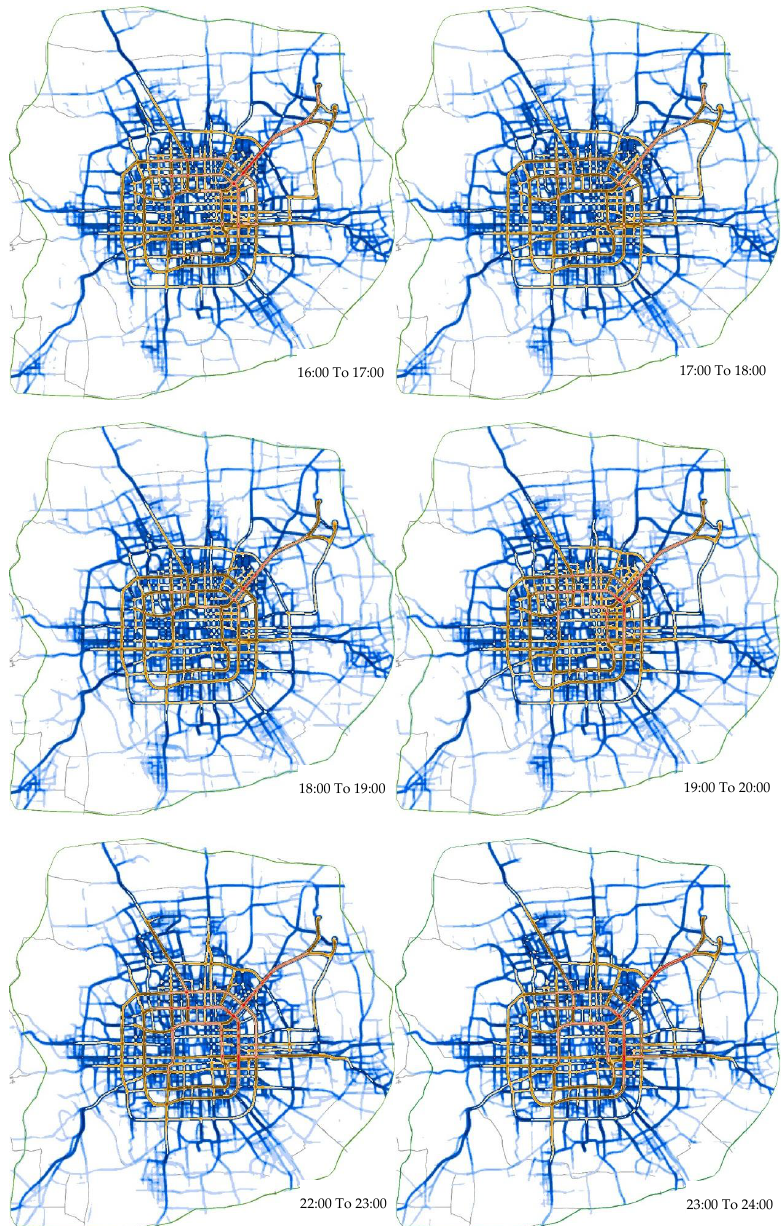
Figure 14. Dynamic distribution of carbon emissions at different time intervals.